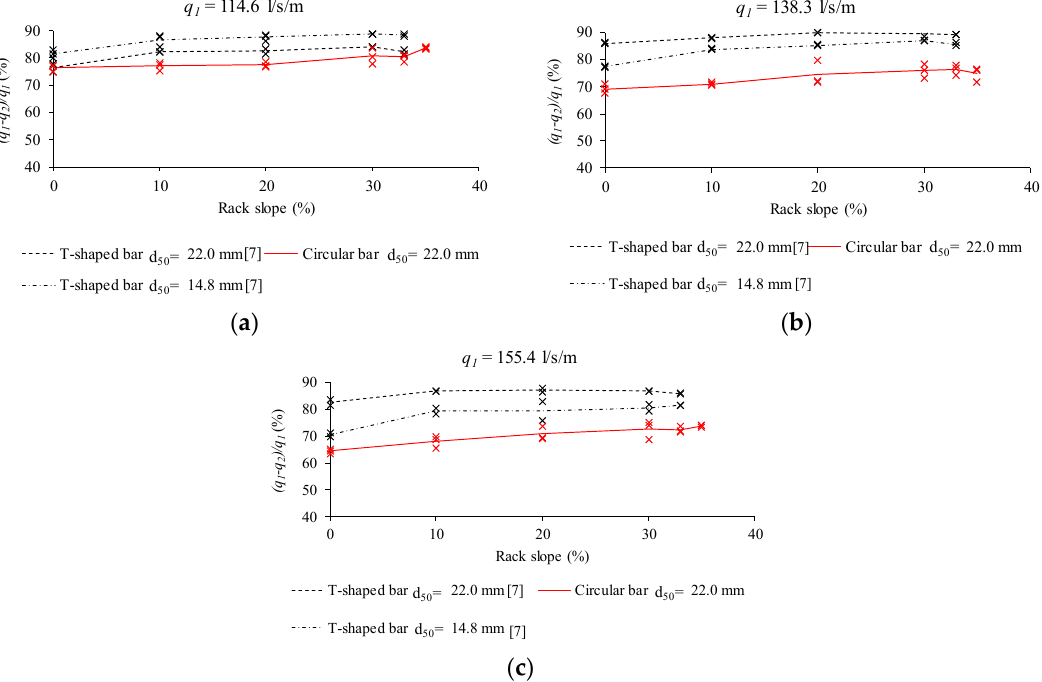
0.000.040.080.120.160.200.240.28